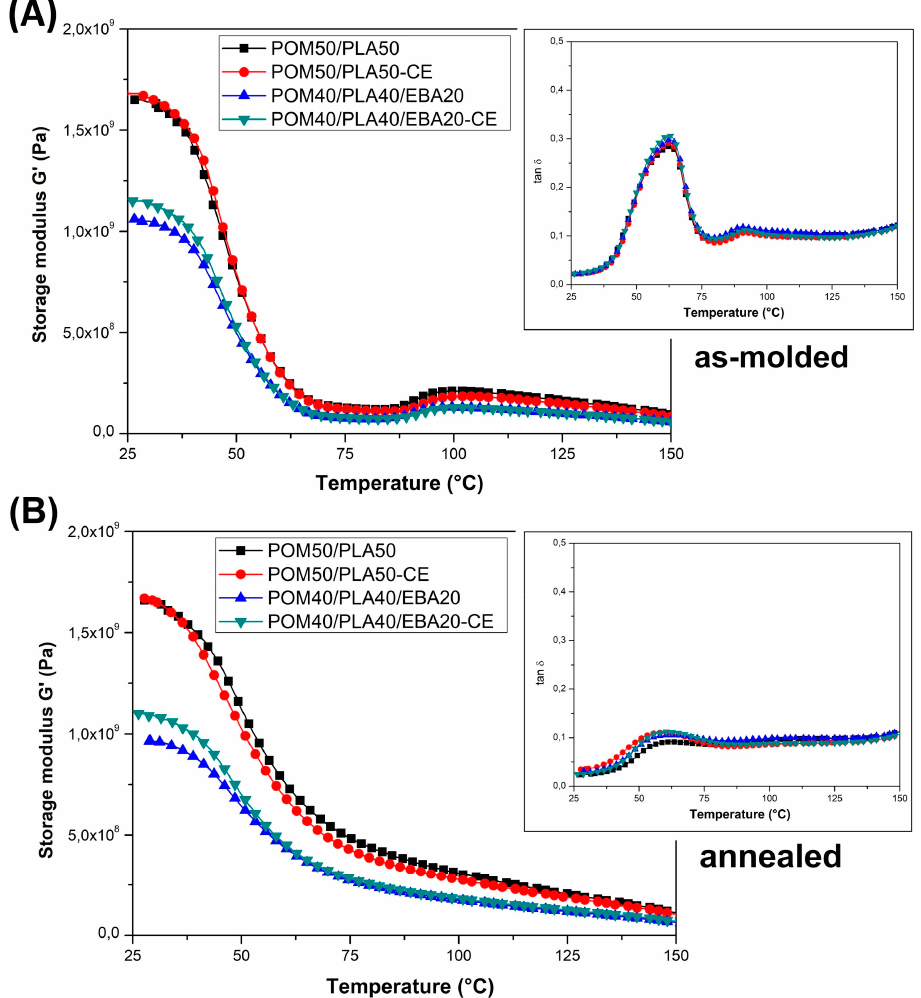
Figure 9. Storage modulus thermograms for the POM / PLA blends. Injection molded samples ( A ) and annealed materials ( B ).